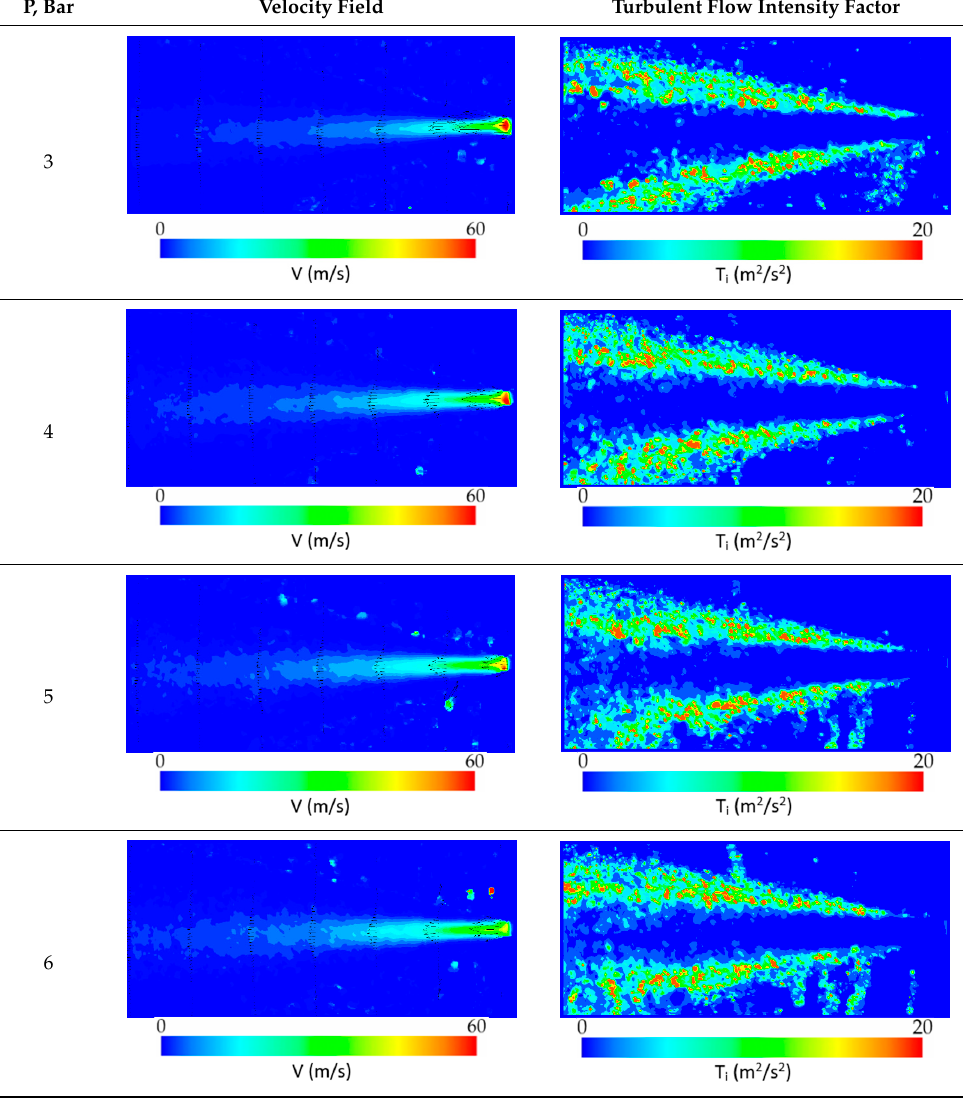
Table 5. Influence of pressure P supplying the nozzle on the character of velocity and turbulent flow intensity factor fields for stub regulation angle α = 45°.